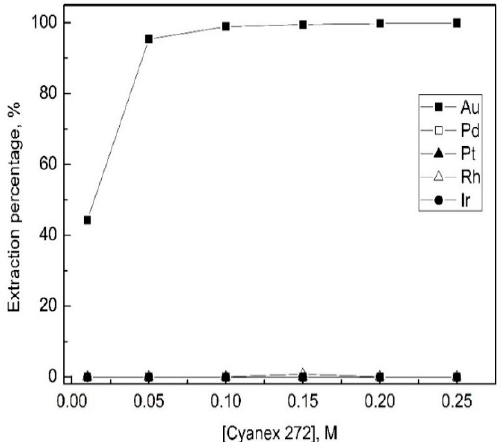
Figure 2. Effect of Cyanex 272 concentration on the extraction of metals containing Au(III), Pd(II), Pt(IV), Rh(III), and Ir(IV). ([HCl] = 5 M, [Au(III)] = [Pd(II)] = [Pt(IV)] = [Rh(III)] = [Ir(IV)] = 100 mg/L).